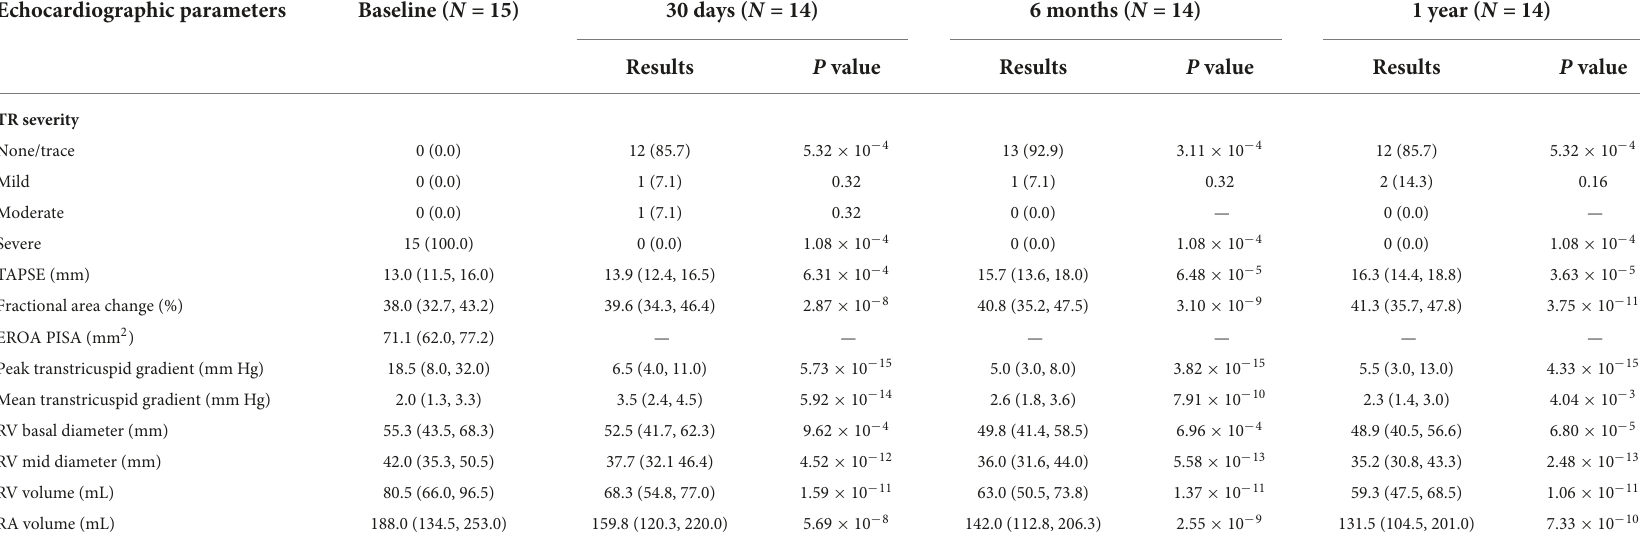
TABLE 5 Baseline to 1-year echocardiographic measurements. Echocardiographic